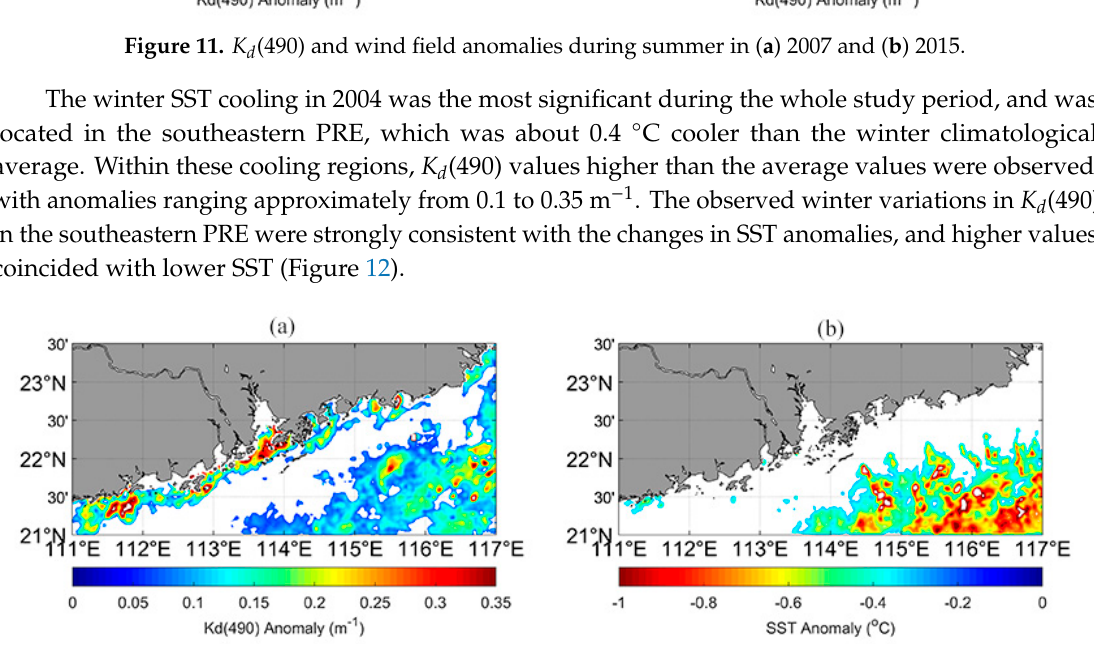
Figure 12. ( a ) K d (490) anomaly during winter 2004 , ( b ) SST anomaly during summer 2004 .